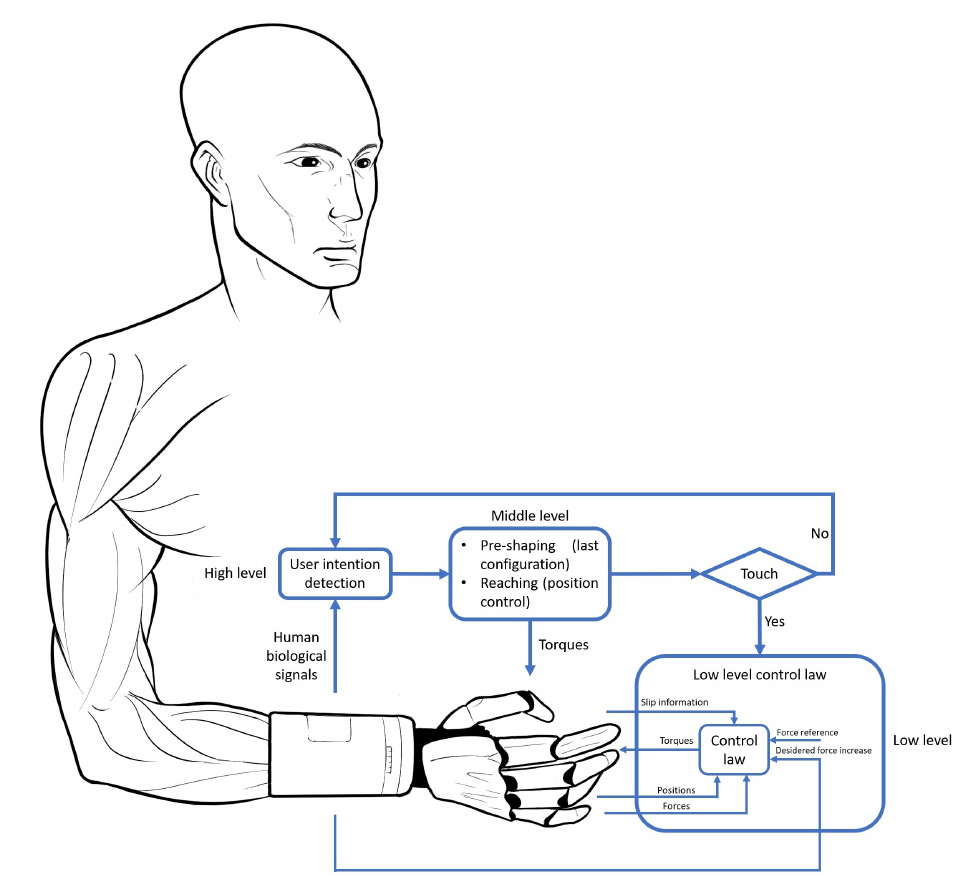
Figure 3. New solution inspired by human hand